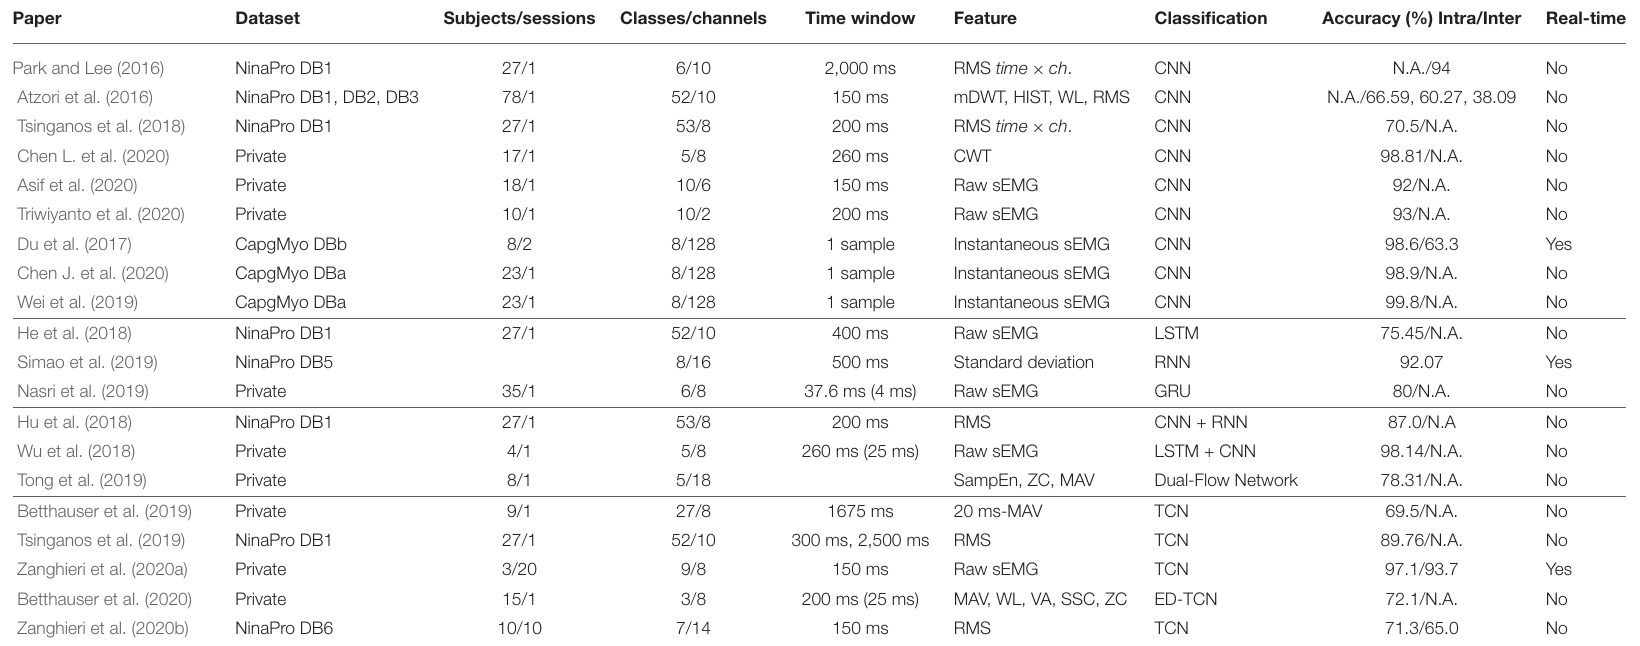
TABLE 2 | Standard structure used by the selected models.